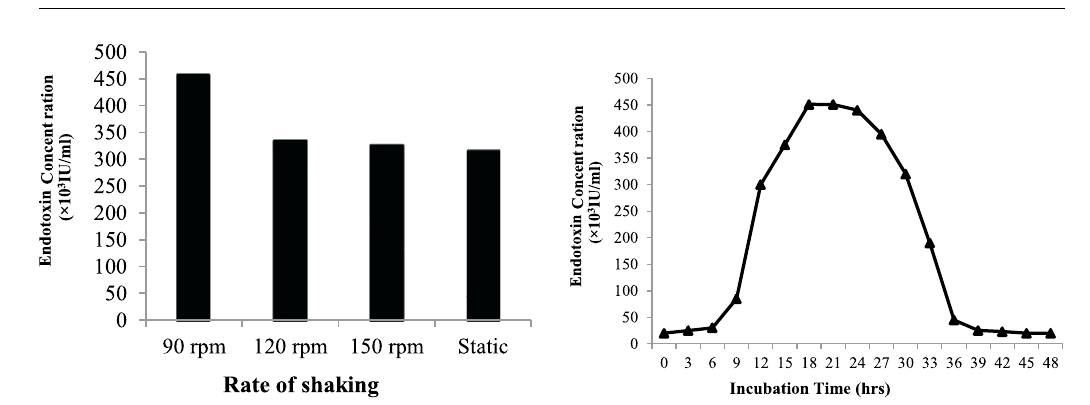
Fig. 2 . Effect of rate of shaking on the endotoxin production by P. aeruginosa ATCC 9027